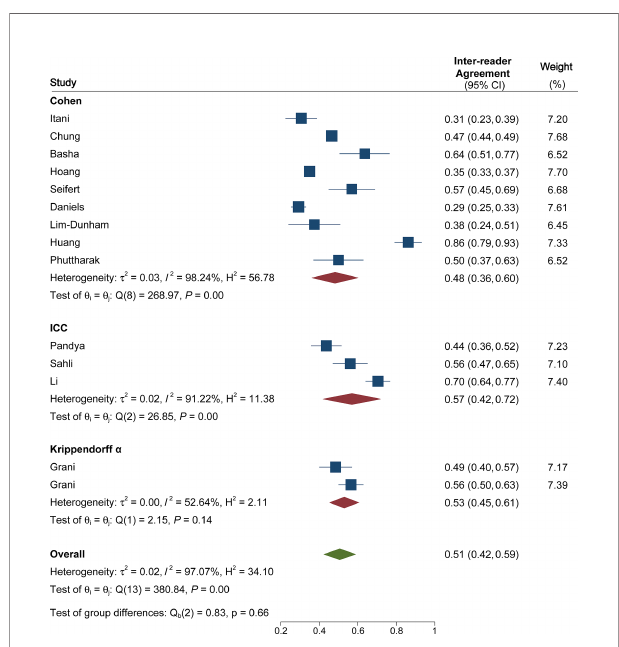
FIGURE 2 | Coupled forest plot of pooled inter-reader agreement of the ACR TI-RADS for classi fi cation of thyroid nodules. ACR, American College of Radiology; TI-RADS, Thyroid Imaging Reporting and Data